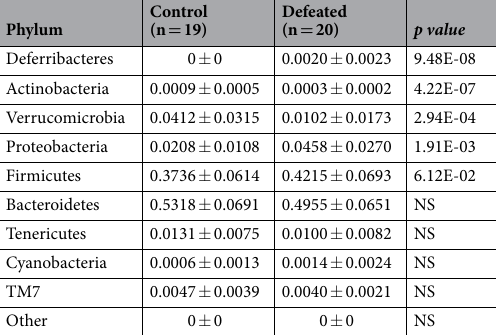
Table 1. Relative abundances of bacterial phyla in control vs . mice exposed to chronic mild social defeat stress. All values are presented as mean ± standard deviation. The phyla are listed in order of significance (Wilcoxon rank sum